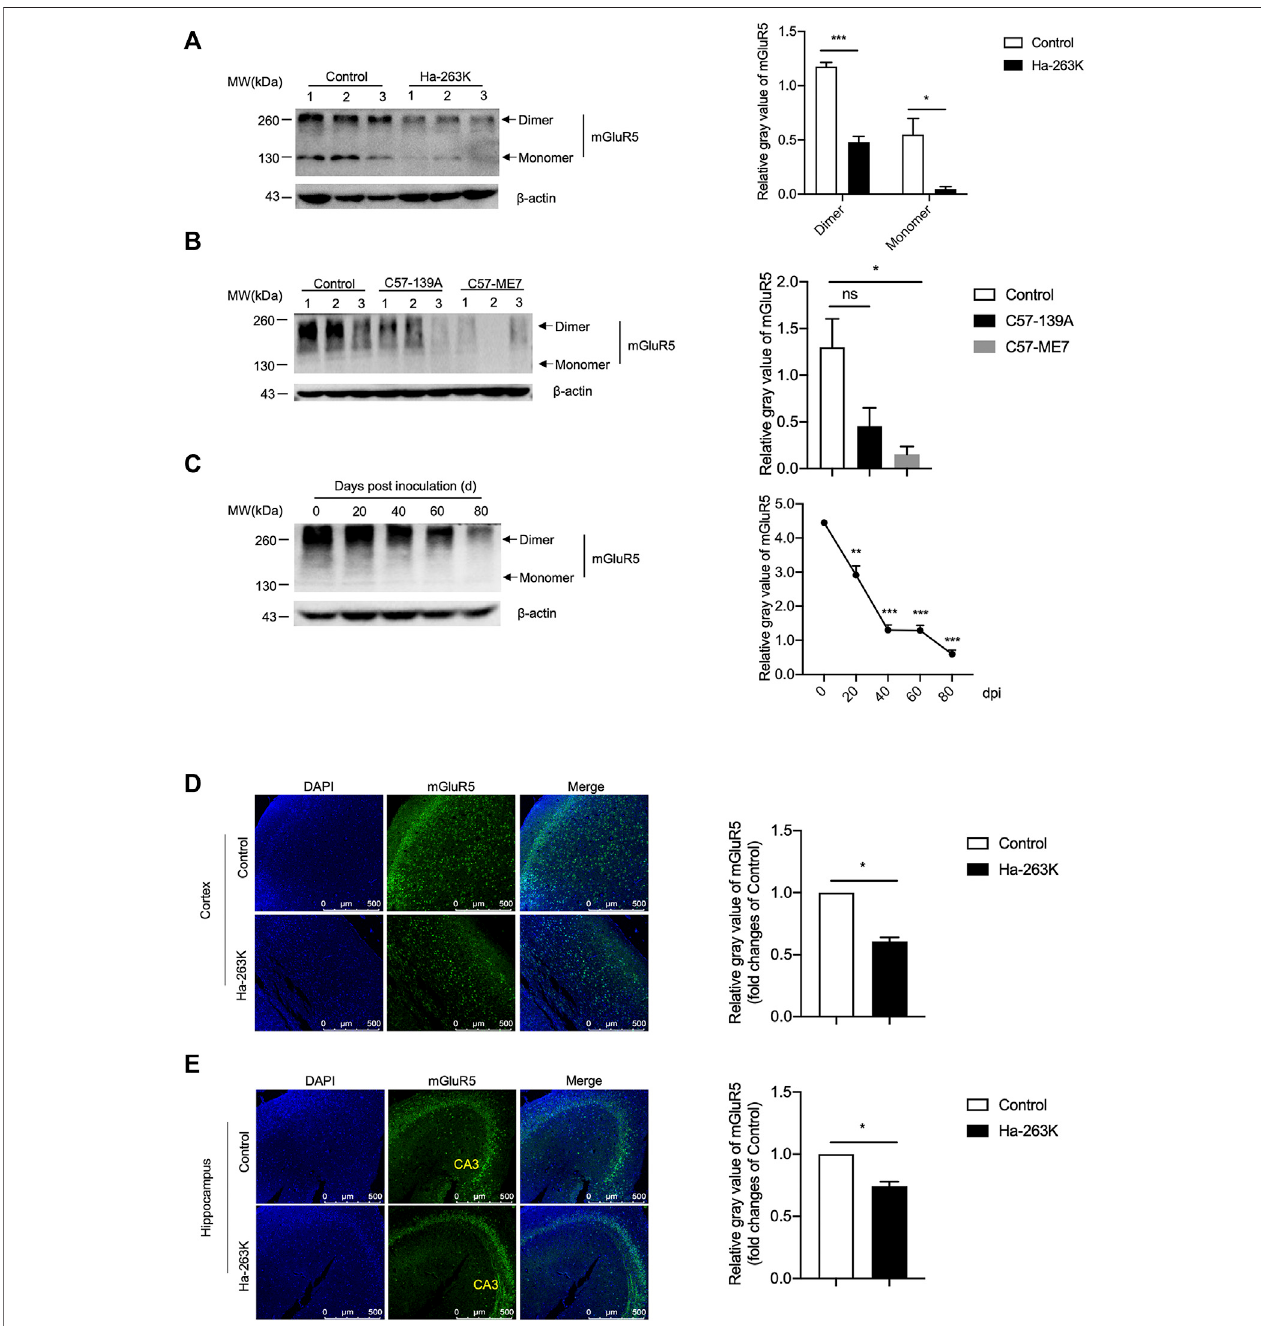
FIGURE 7 | The levels of mGluR5 in the brains of scrapie-infected rodent models. (A-B) Left: Western blots for the levels of mGluR5 in brains of 263 K-infected hamsters (A) and 139 A or ME7-infected mice (B) . Various prion-infected rodent models are indicated above. (C) Left: Dynamicassays of thelevels ofmGluR5 in brains tissuesof263 K-infectedhamstersduringtheincubationperiod.Thedataofdpiareshownatthetop.Relativemolecularweightsaremarkedontheleft.(1,2,3)indicate the number of replicates. Right: Densitometric analyses of the average gray values of the signals of the mGluR5 after being equilibrated with that of β -actin. (D-E) Left: Immuno fl uorescent staining of mGluR5 in cortex (D) and hippocampus (E) regions of 263 K-infected hamsters. The images of DAPI (blue), mGluR5 (green) and merge are indicated above. Right: The IOD analysis for the signals of mGluR5 in the images of cortex and hippocampus sections. The IOD value of mGluR5 in control is set to 1 and Y -axis represents the fold changes in Ha-263 K versus control brains.